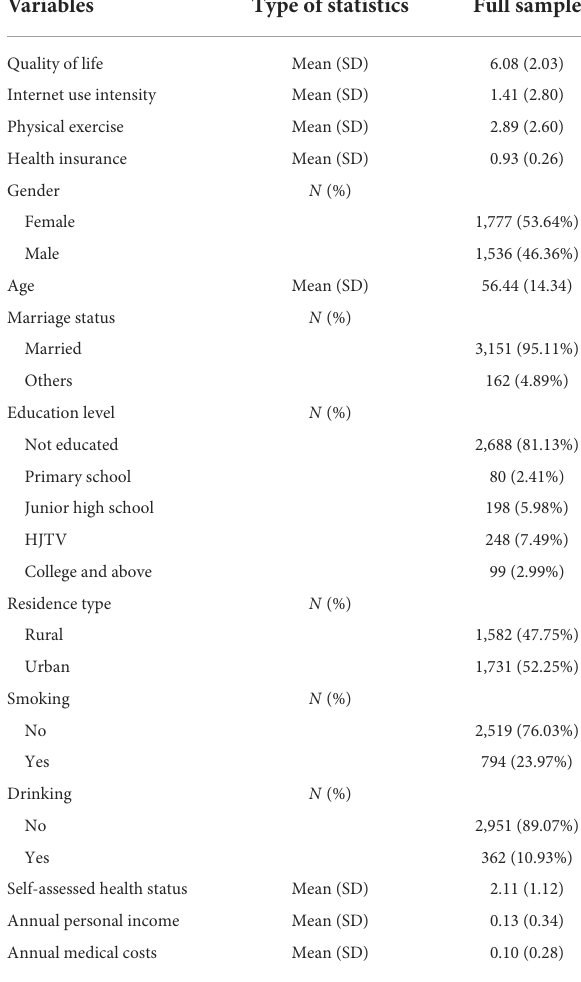
TABLE 1 Descriptive statistics of all variables ( N =